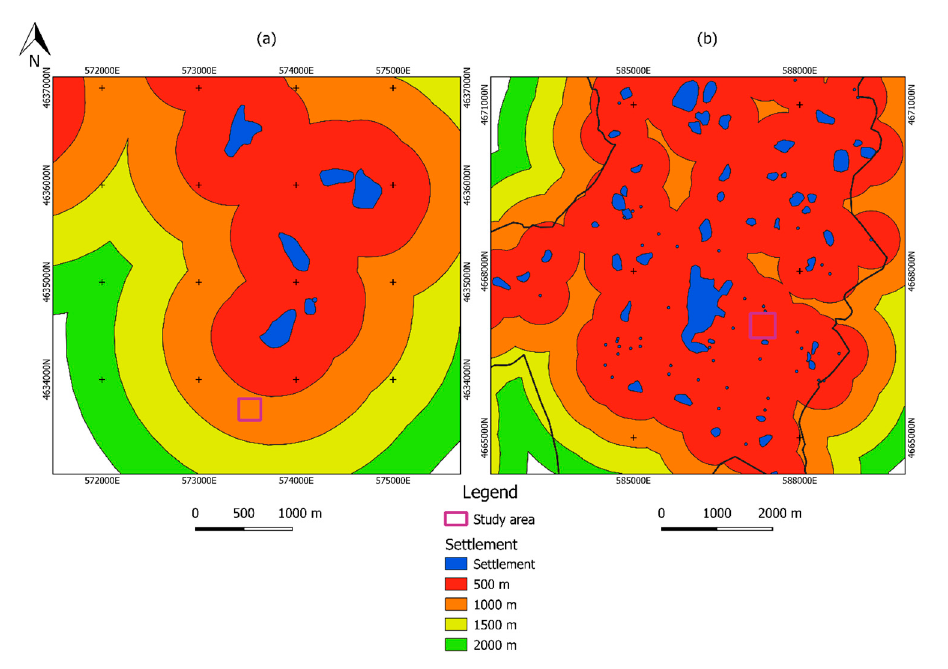
Figure 6. Settlement maps. ( a ) Settlement distances map of study area A; ( b ) settlement distances map in study area B. The map coordinate system is EPSG:25829 ETRS89/UTM zone 29N.